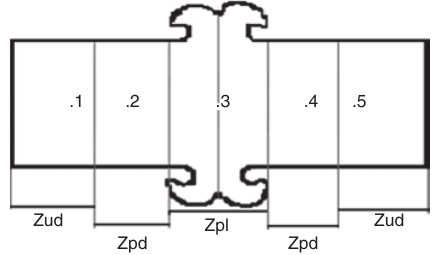
Figure 14 Microhardness zones.